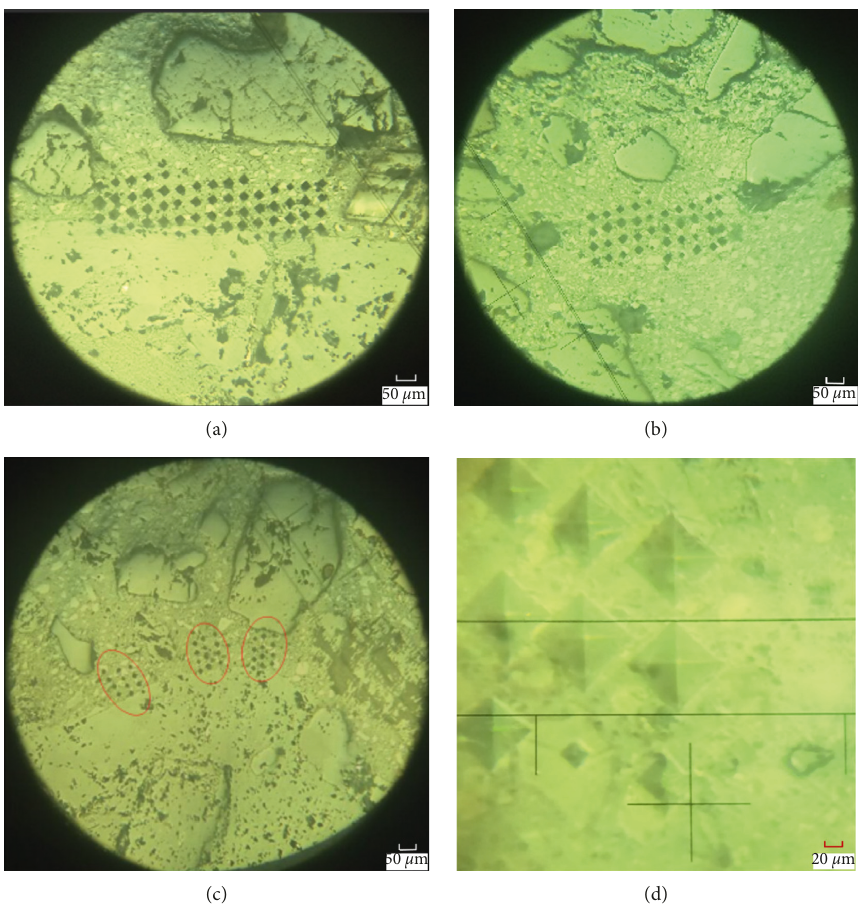
Figure 3: Three types of interface positions and RBI directions: (a) LG-XJ interface matrix point group; (b) LJ-XJ interface matrix point group; (c) LG-LJ interface vertical single-line point group; (d) the typical indent for microhardness test.